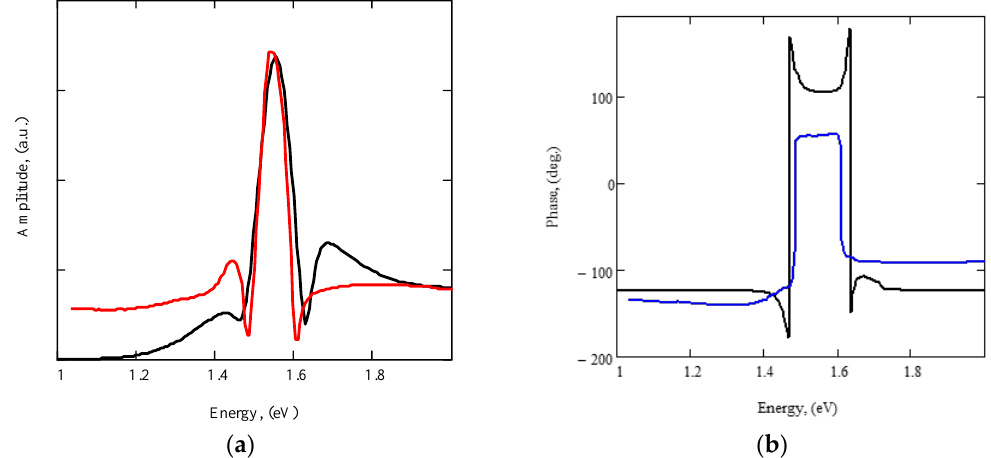
Figure 9. Amplitude ( a ) and phase ( b ) spectra of the ground Cd 0.95 Be 0.05 Te mixed crystal for 126 Hz modulation frequency. Simulated spectra are presented by black lines, experimental amplitude by red lines, and experimental phase by blue lines.